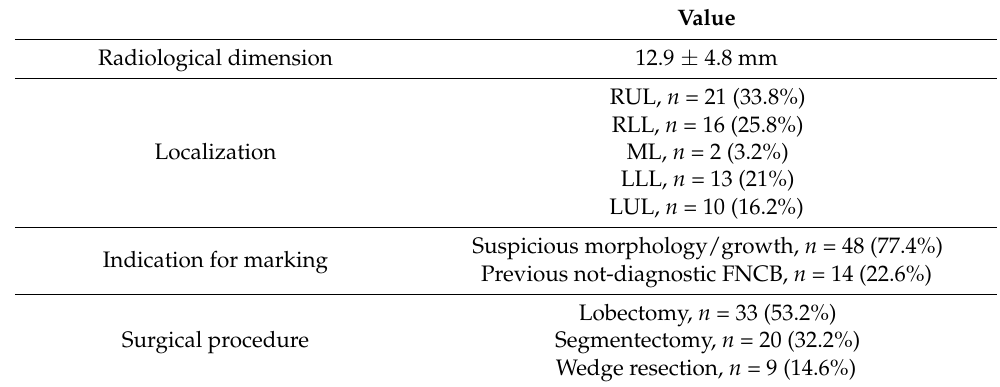
Table 1. Lesions’